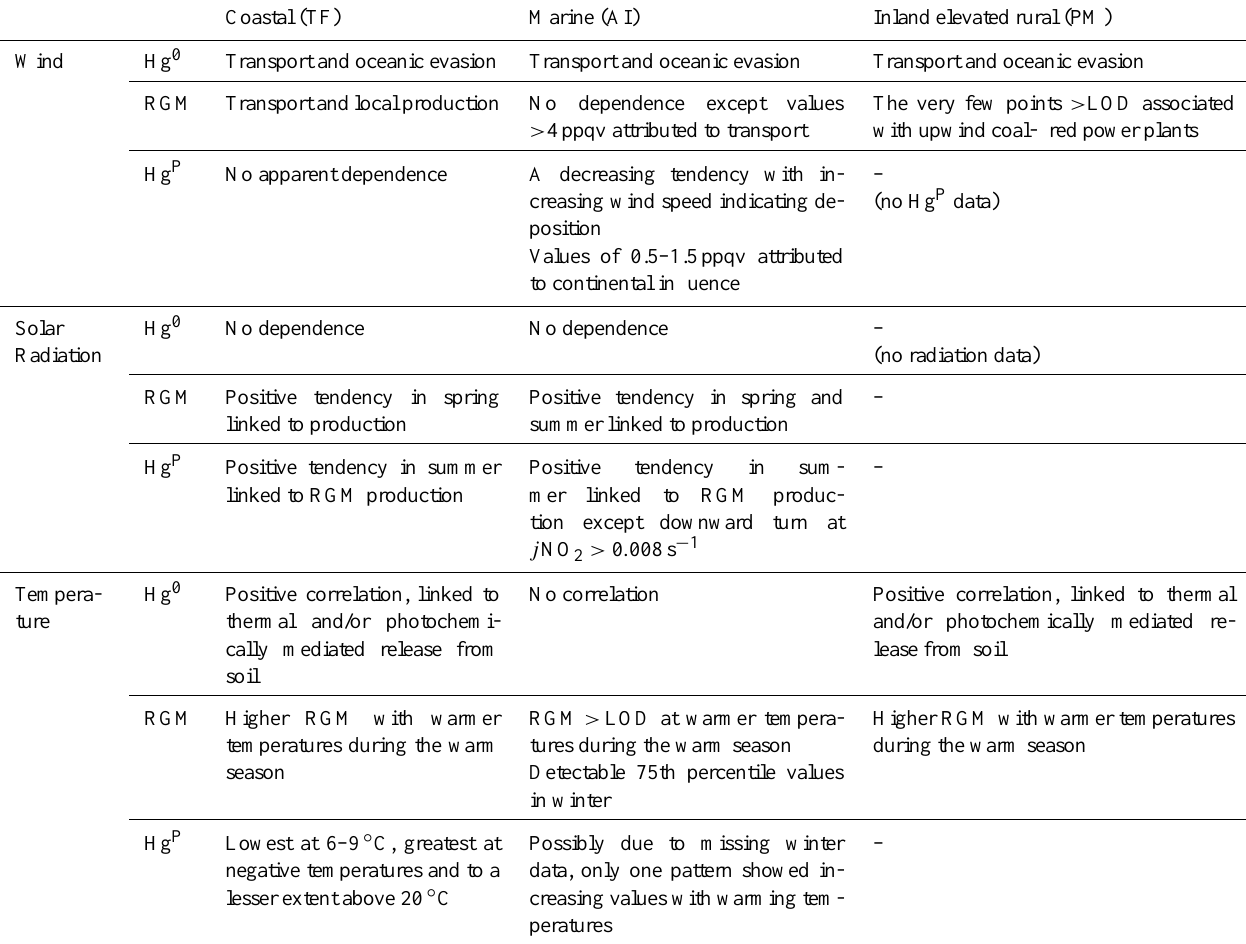
Table 5. Summary of key results in the coastal, marine, and inland environments. Coastal (TF) Wind Hg 0 Transport and oceanic evasion